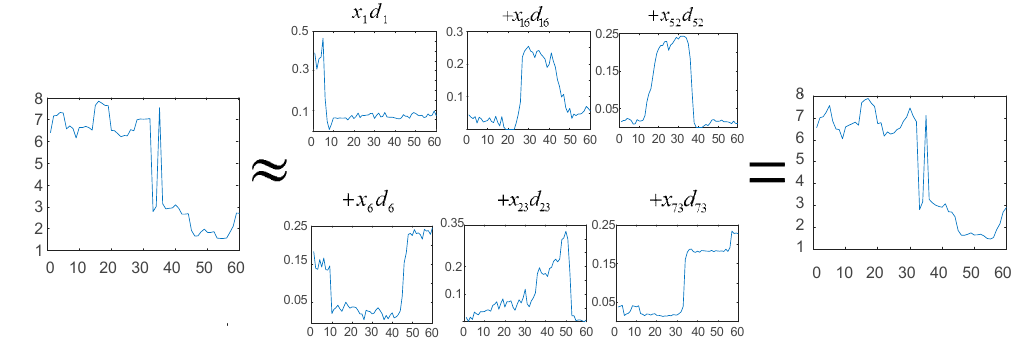
Figure 1. Schematic diagram of sparse coding.